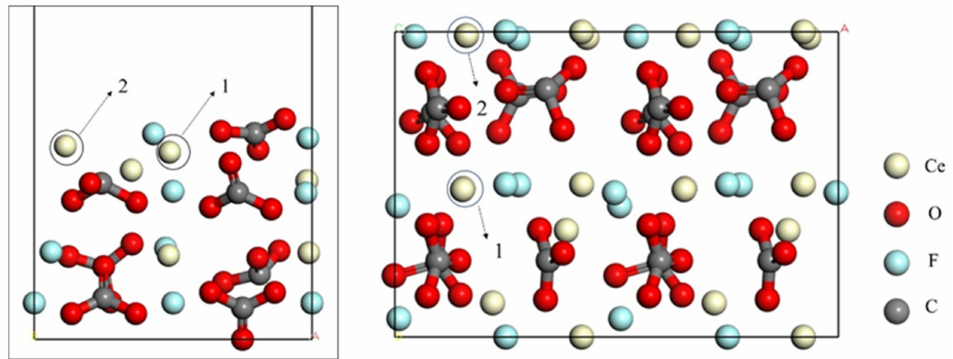
Figure 6. Two possible locations (1 and 2) for the substitution of Ce by La: ( left ) side view and ( right ) top view. Table 3. The La atom replaces the Ce atom; the hydroxylated Mulliken population of the bastnaesite (100) surface.